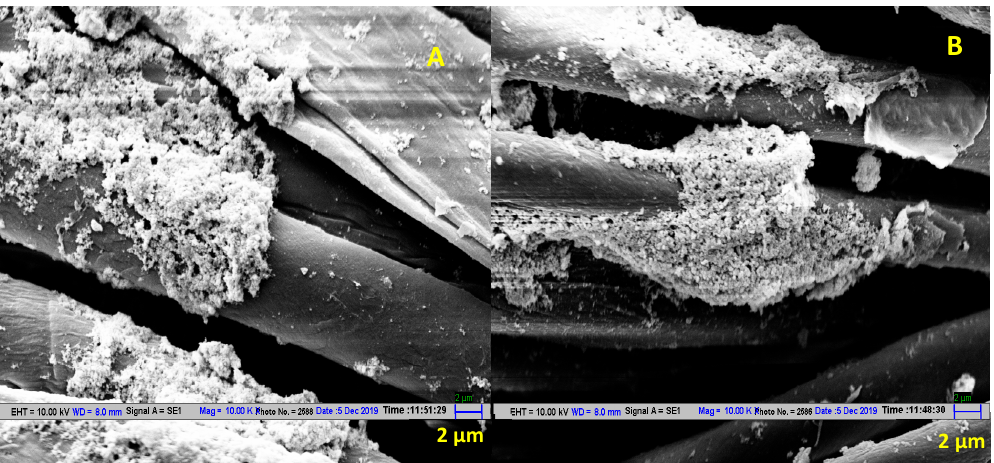
Figure 3. SEM micrographs of mercerized cotton fabric treated by AgNP via in situ synthesis by reacting 2 mM AgNO 3 with 20% ( w/v ) Azadirachta indica leaf extract in a ratio of 9:1 at pH 7.1. ( A ) Before washing. ( B ) After 20 washes.